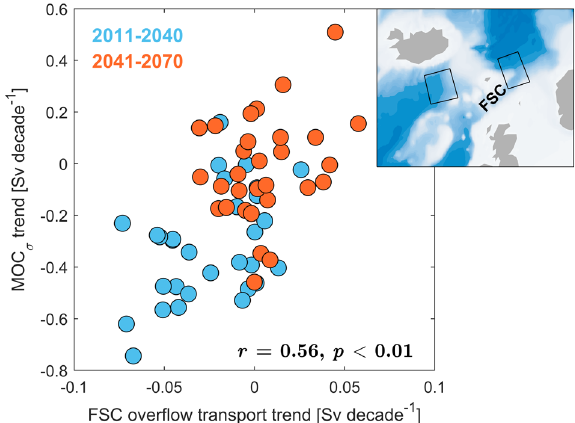
Fig. 8 | Nordic Seas over fl ow. Ensemble trend correlation between Nordic Seas overturning strength (MOC σ ) and over fl ow transport through the Faroe-Shetland Channel (FSC) in CESM-LE. Blue circles show 30-year trends for 2011 – 2040, while red circles show trends for 2041 – 2070. Considering both periods, the correlation ( r )is0.56( n =60).Theregionsusedintheover fl owparameterization 39 areshownin the inset